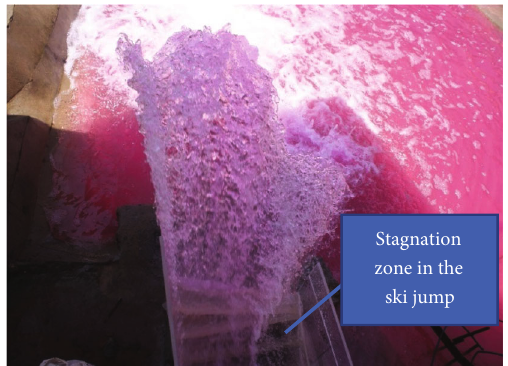
Figure 14: The stagnation zone of the fl ow in the ski jump-physical model.